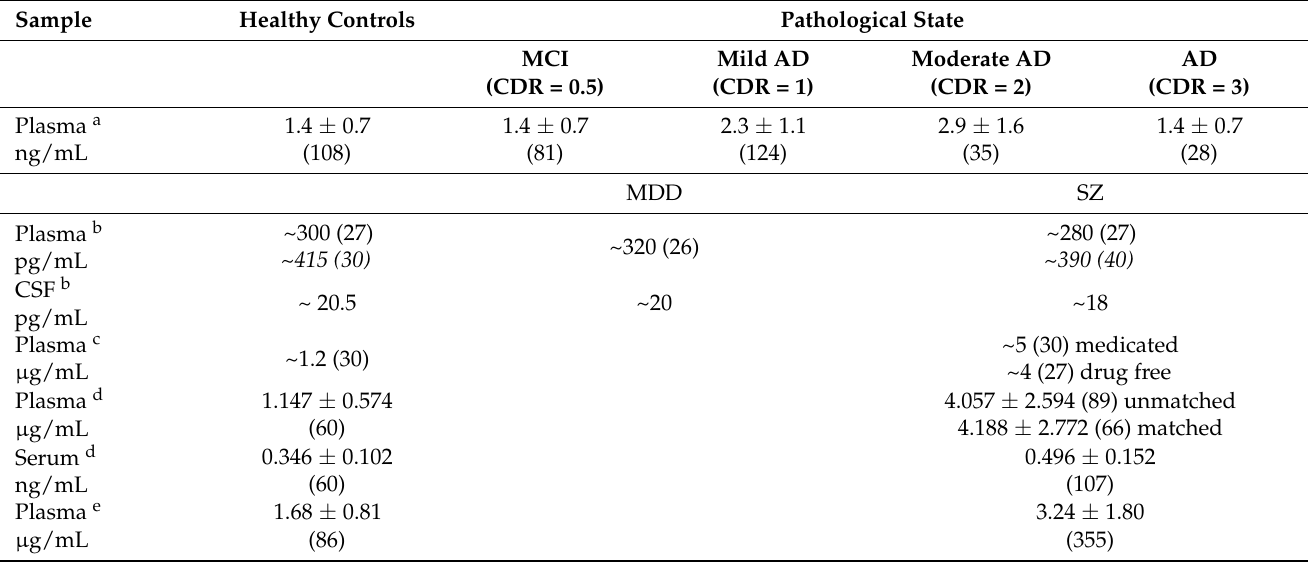
Table 1. pLG72 levels in human plasma of healthy controls and patients affected of MDD, AD and SZ. The number of analyzed samples is reported in parenthesis and the replication group is depicted in